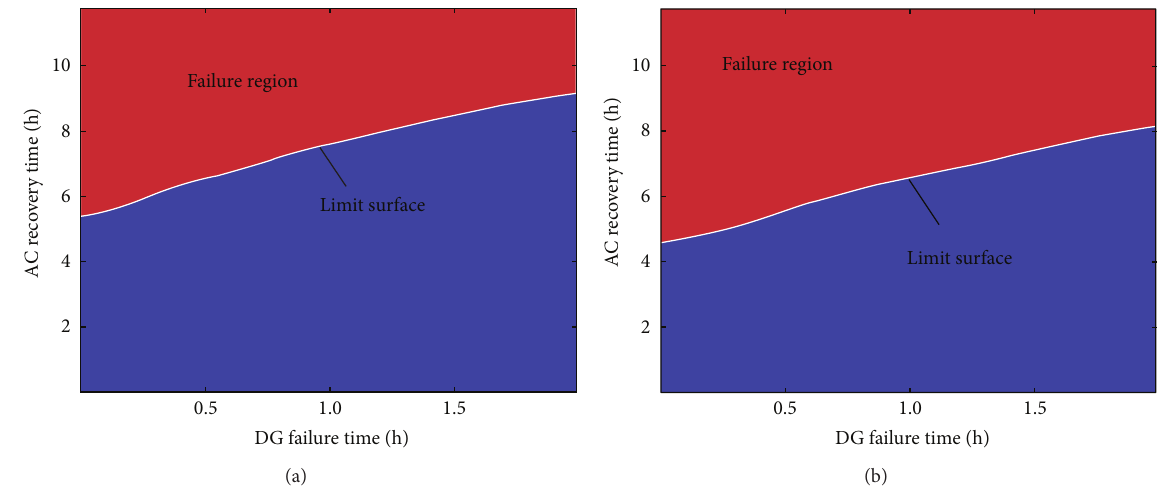
Figure 18: Limit surface for 100% (a) and 120% (b) cases: AC recovery time versus DG failure time. Note how the failure region Ω 𝐹 (red area) expands if power increases from 100% to